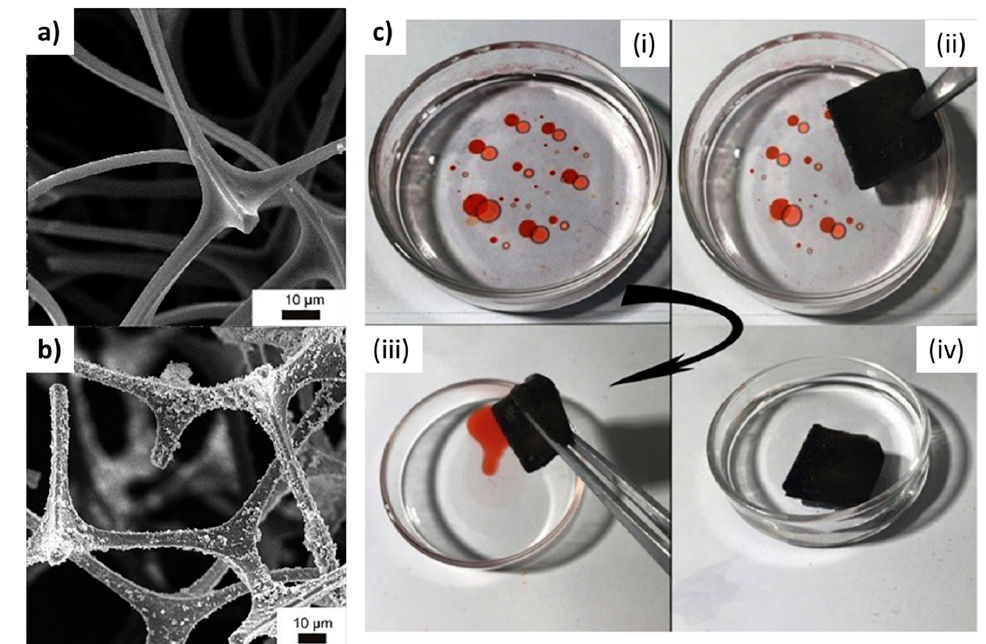
Figure 9. ( a ) SEM images of pristine PU sponge, ( b ) SEM images of PU-LDH-Fe 3 O 4 -PDA-OM sponge, ( c ) A series of photographs for the process of absorption and collection toluene (dyed with Sudan III) from the surface of water. Reprinted from Ref. [127] with permission from Elsevier.